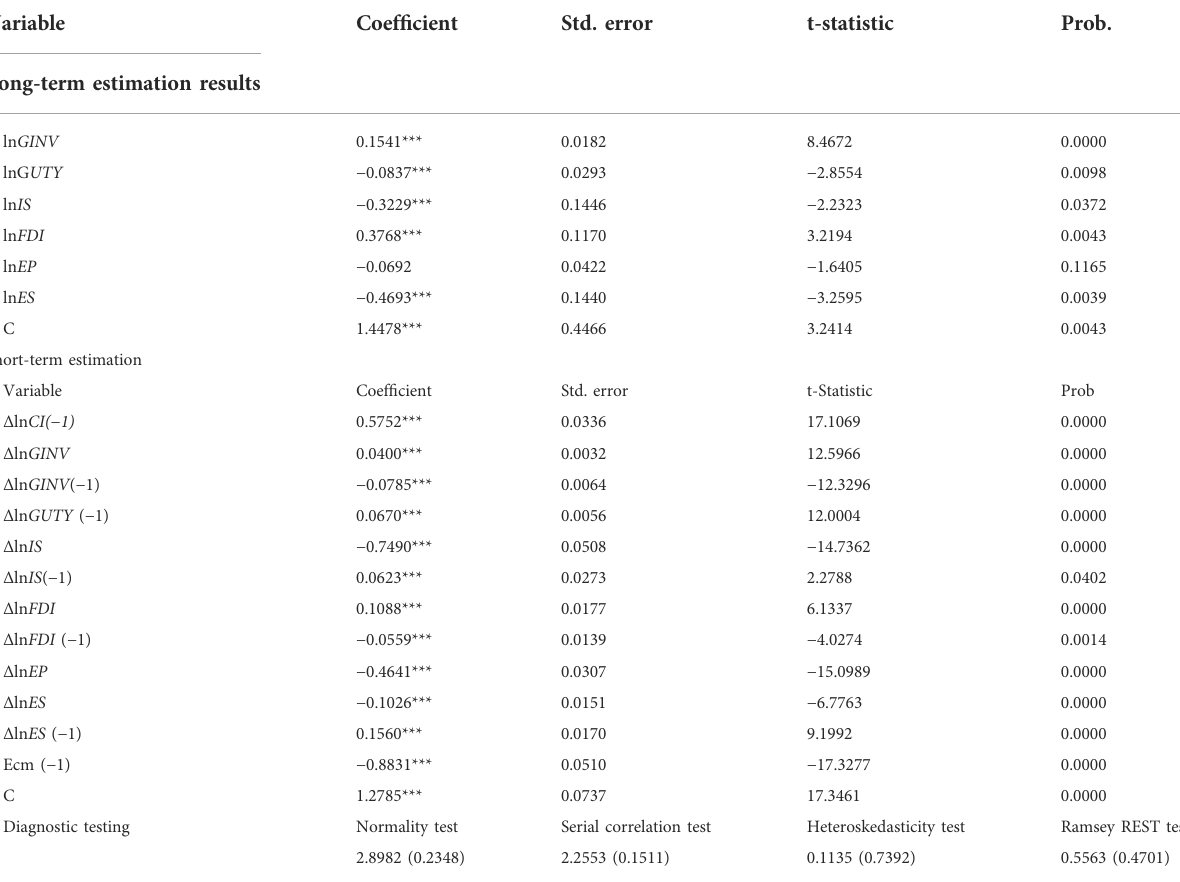
TABLE 4 Estimation results of a long-term relationship and short-term dynamic coef fi cients.